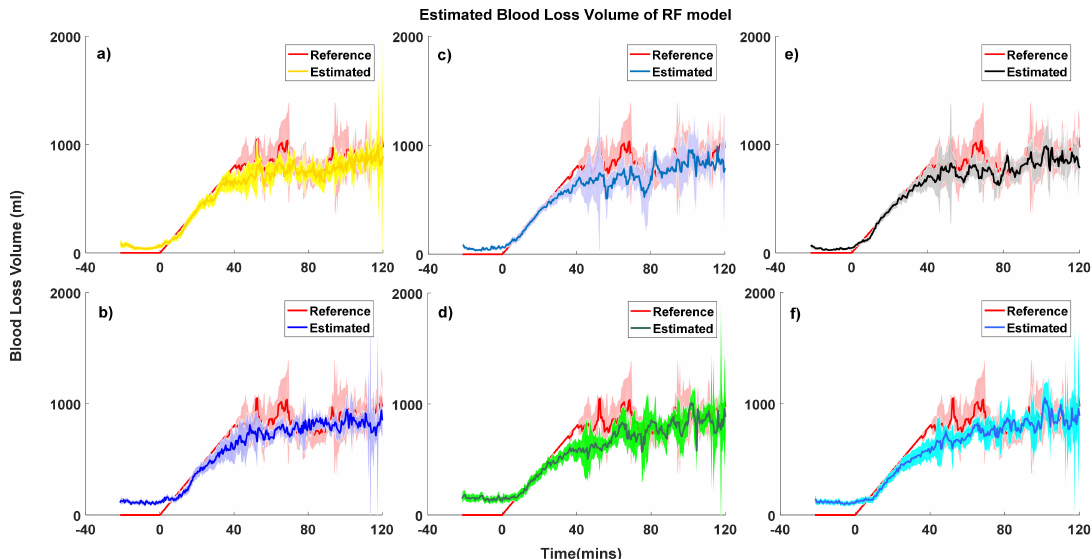
Figure 2. Estimated and reference blood loss curves of the random forest (RF) model with 95% confidence intervals. ( a )Arterialbloodpressure(ABP)personalmodel,( b )ABPgroupedmodel,( c )photoplethysmography (PPG) personal model, ( d ) PPG grouped model, ( e ) arterial blood pressure and photoplethysmography (ABP&PPG) personal model, and ( f ) ABP&PPG grouped model.